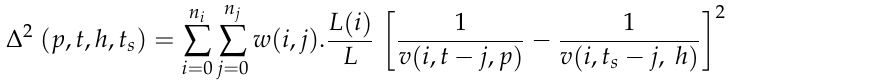
Table 1. Values for highway links.